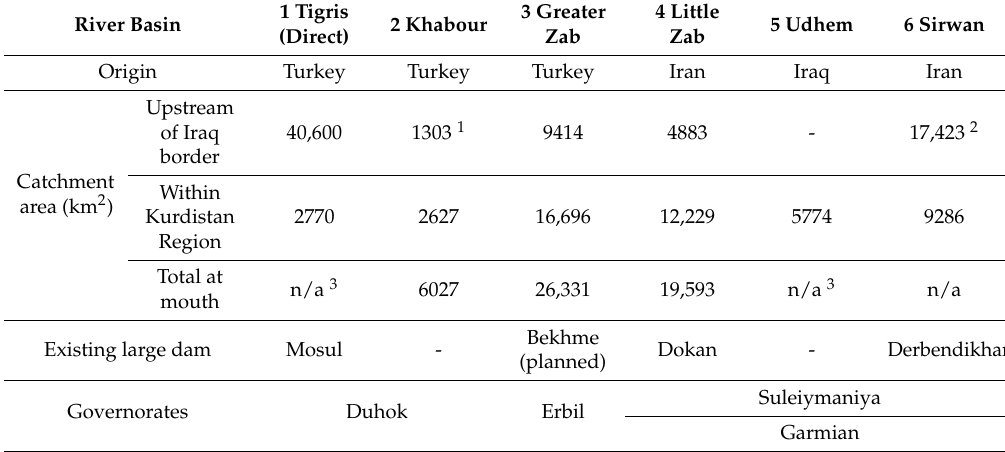
Table 2. River basins in Northern Iraq, data source